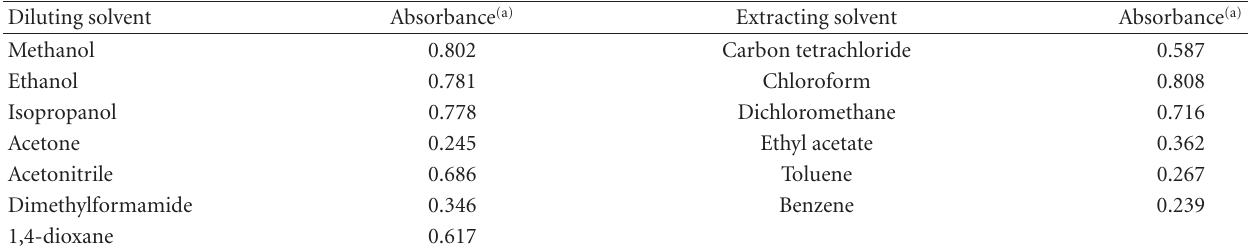
Table 1: E ff ect of diluting and extracting solvents on the intensity of the reaction product of PRX with NQS.